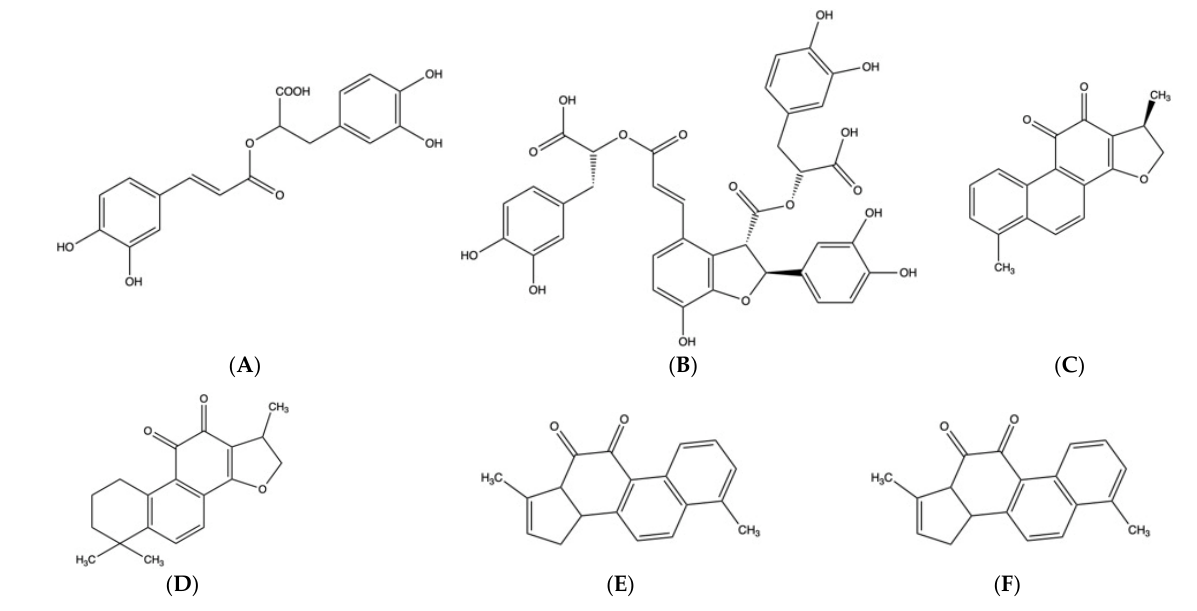
Figure 1. The plant and main medicinal material of S. miltiorrhiza used in the pharmaceutical indus- try. From left to right: whole plants, leaves, stems, flowers, roots and pieces.